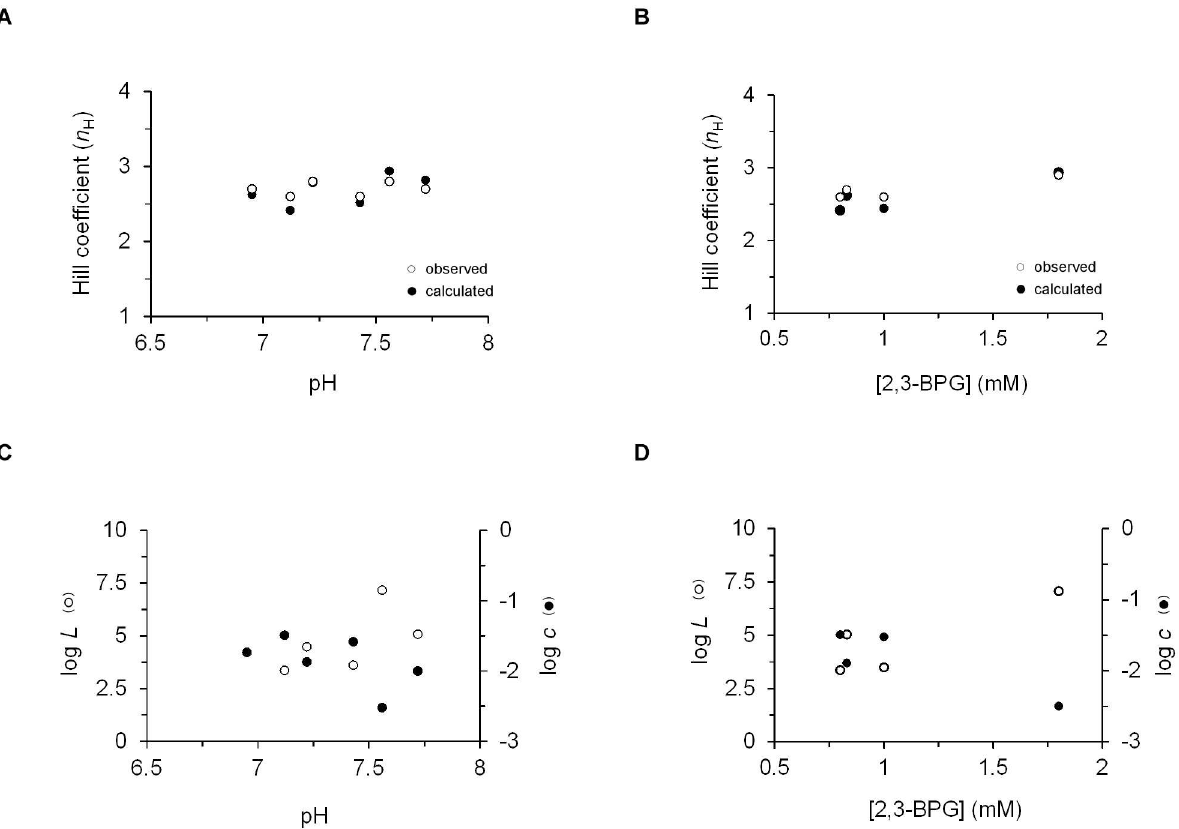
Fig 2. The three-equation systemstrategyis inadequate for assessing the effect(s) of physiological variations on allosteric protein function. (A-B) Correlationplot relatingthe observed(open circles) and calculated(filled circles) n H values of the different dataset oxygenation curves to either pH (A) or 2,3-BPG (B) effector concentrations (S1 Table; see Methods). (C-D) Dependence of the L and c parameters of the physiological datasets on pH (C) and 2,3-BPG concentrations (D). A similar analysisof additionalpH and 2,3-BPG physiological datasets, collected under different experimental conditions(see S1 Table), is presented in S2 Fig.